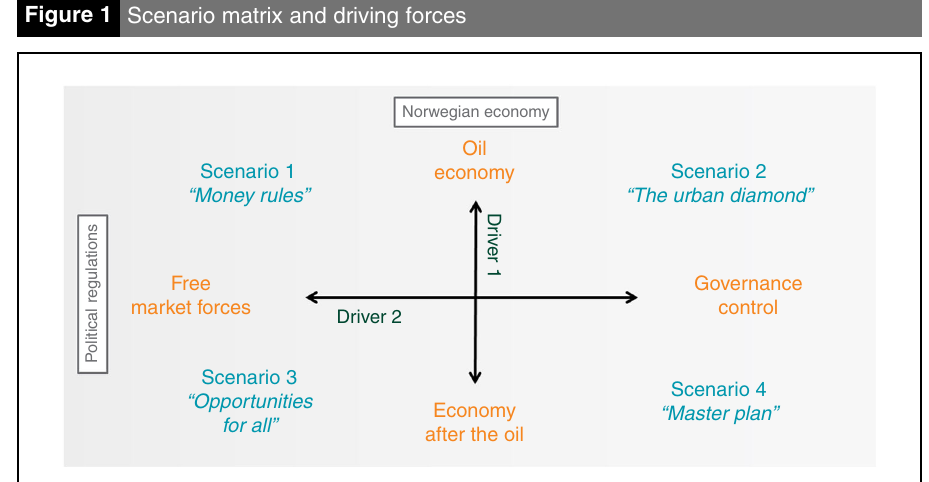
Figure 1 Scenario matrix and driving